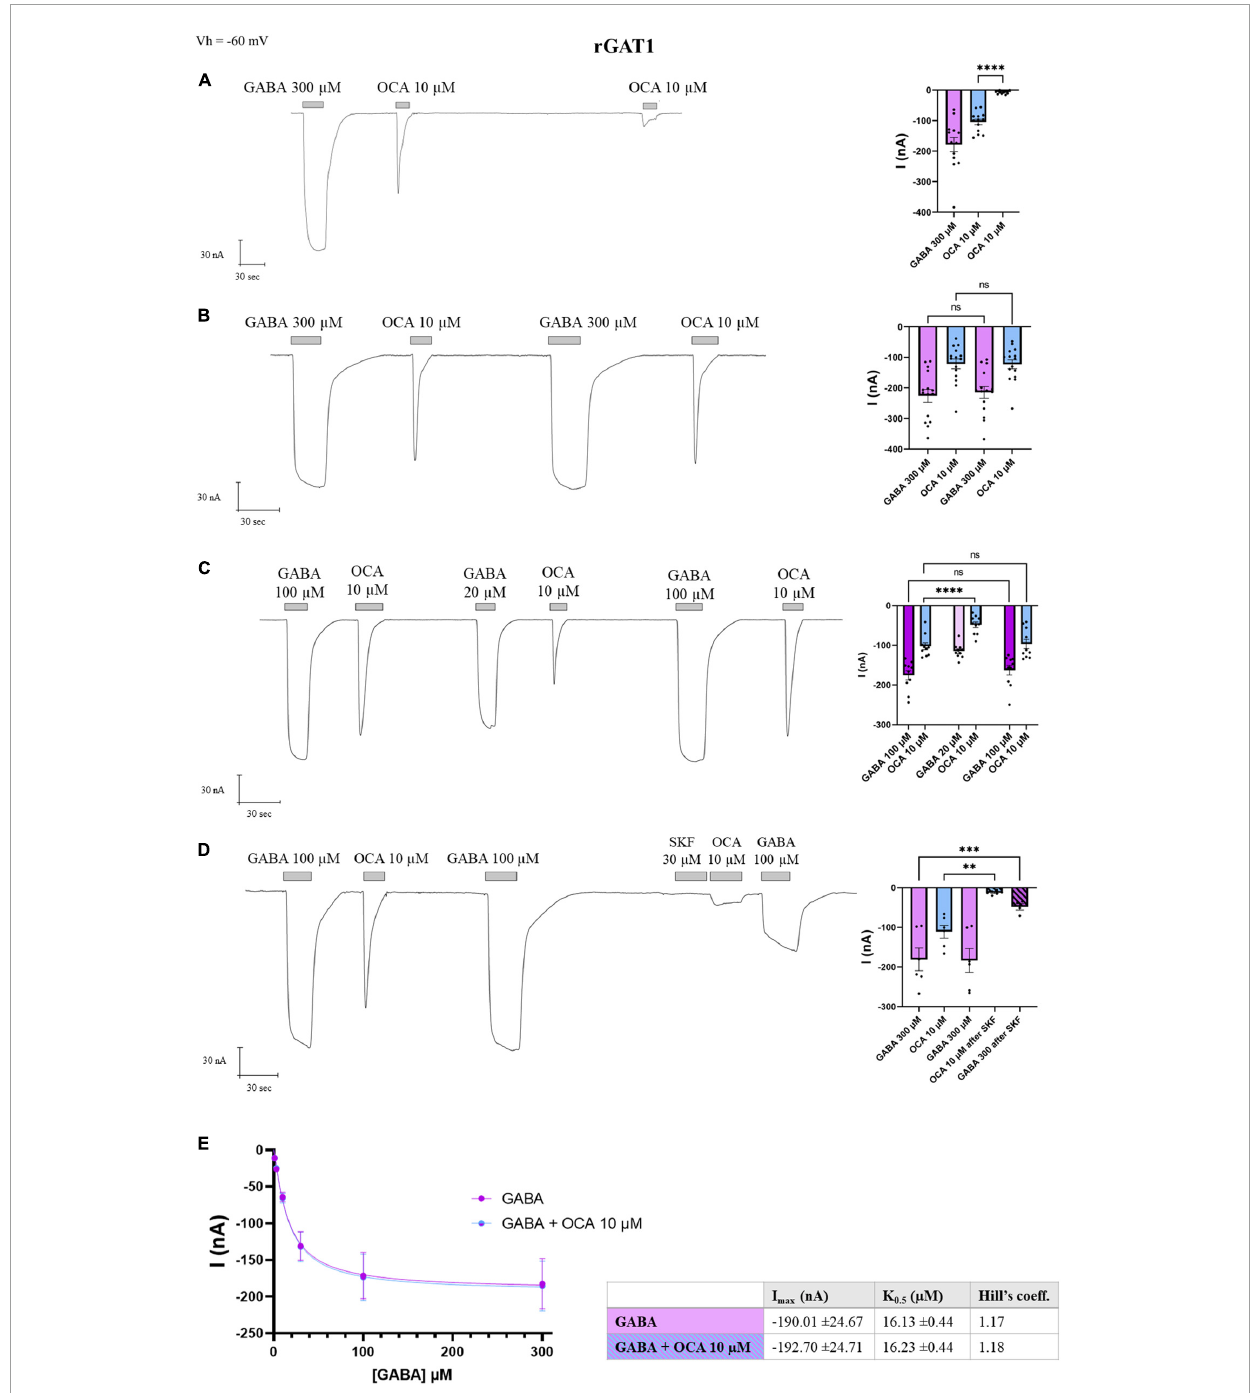
FIGURE5 Obeticholic acid (OCA) relationship with rGAT1. Representative traces of currents recorded by TEVC from oocytes expressing rGAT1 exposed to OCA (left) and mean of the indicated currents (right). (A) Currents after the first and second exposure to OCA with an interval of 5 (cid:48) wash with ND98 alone; mean current (nA) ± SE of 13/3 n/N; one-way ANOVA F ( 2 , 36 ) = 35.68, ∗∗∗∗ p < 0.0001 followed by Bonferroni’s multiple comparison test: I 0 OCA vs. I’ OCA : ∗∗∗∗ p < 0.0001. (B) Currents after the first and second exposure to OCA with washing ND98 and ND98 plus GABA 300 µ M after the first OCA exposure; mean current (nA) ± SE of 15/3 n/N; repeated measure one-way ANOVA F ( 1 . 246 , 17 . 44 ) = 45.80, ∗∗∗∗ p < 0.0001 between columns and F ( 14 , 42 ) = 14.93, ∗∗∗∗ p < 0.0001 between rows followed by Bonferroni’s multiple comparison test. I GABA vs. I’ GABA : p = 0.1599 and I 0 OCA vs. I’ OCA : p > 0.9999. (C) Currents after the first and second exposure to OCA with washing ND98 and ND98 plus GABA 20 µ M after the first OCA exposure; mean current (nA) ± SE of 10/2 n/N; repeated measure one-way ANOVA F ( 1 . 765 , 15 . 89 ) = 38.97, ∗∗∗∗ p < 0.0001 between columns and F ( 9 , 45 ) = 10.44, ∗∗∗∗ p < 0.0001 between rows followed by Bonferroni’s multiple comparison test. I µ M vs. I’ µ M: p > 0.4177; I 0 GABA 100 GABA 100 OCA vs. I’ OCA after GABA 100 µ M: p > 0.9999; I 0 OCA vs. I’ OCA after GABA 20 µ M: ∗∗∗∗ p < 0.0001. (D) Current after SKF 30 µ M perfusion, followed by the second OCA; mean current nA ± SE of 6/2 n/N; one-way ANOVA F ( 3 , 18 ) = 17.02, ∗∗∗∗ p < 0.0001 followed by Bonferroni’s multiple comparison test: I 0 OCA vs. I’ OCA after SKF: p = 0.0019; I GABA vs. I’ GABA after SFK: p = 0.0003. (E) Data from 8/1 n/N cells perfused with increasing concentrations of GABA from 3 to 300 µ M with or without OCA 10 µ M were fitted to Hill’s equation and the data reported in the table (I max : p = 0.9523; K 0 . 5 : p = 0.8170). ∗∗ p < 0.01, ∗∗∗ p <